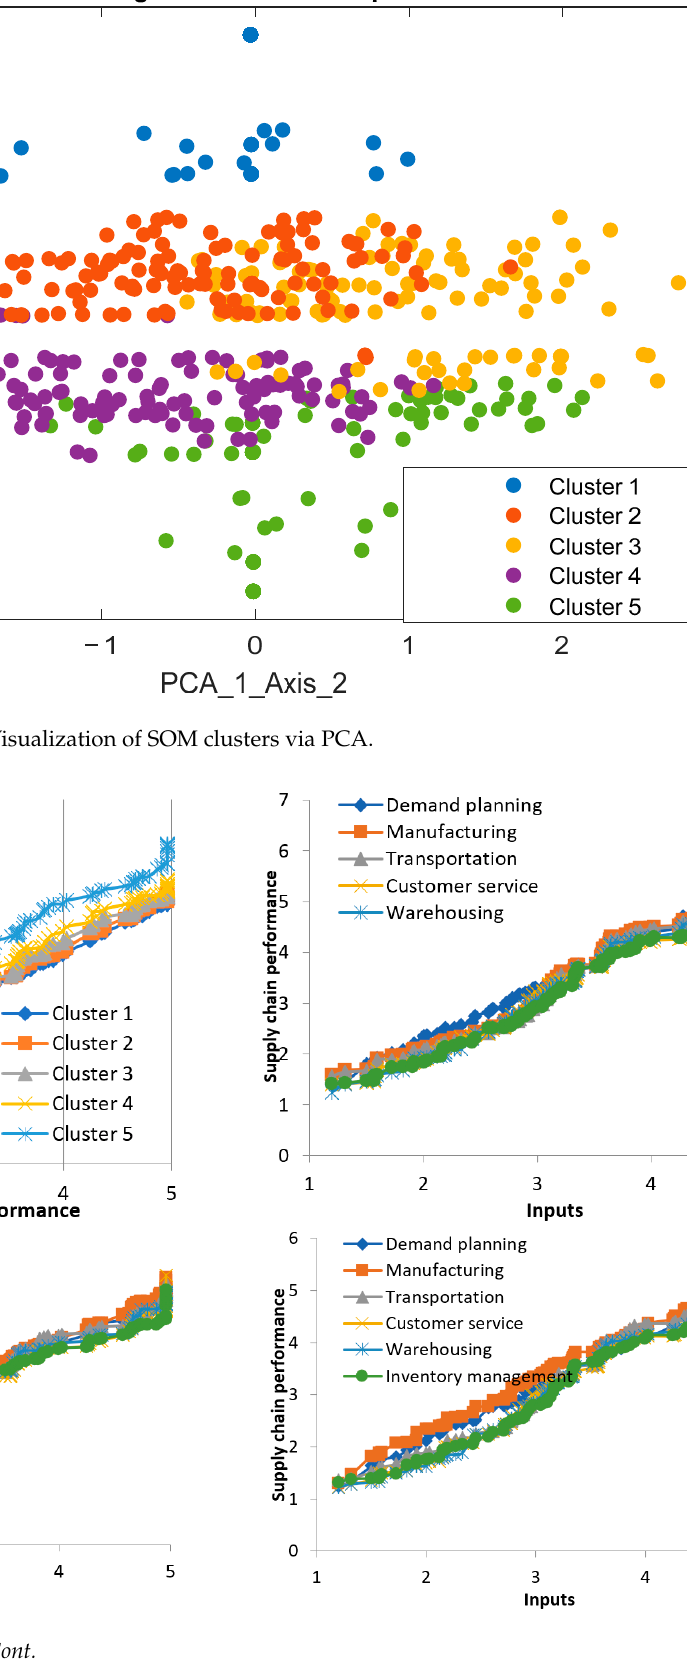
Figure 4. The relationships between demand planning, manufacturing, transportation, customer service, warehousing, inventory management, supply chain performance, and company performance. Evaluation Metrics In this study, we used three statistical performance metrics to determine the efficiency and accuracy of the prediction models using decision trees. These were the root mean square error (RMSE) [84], mean absolute error (MAE) [85] and the coefficient of determination (R 2 ) [86].